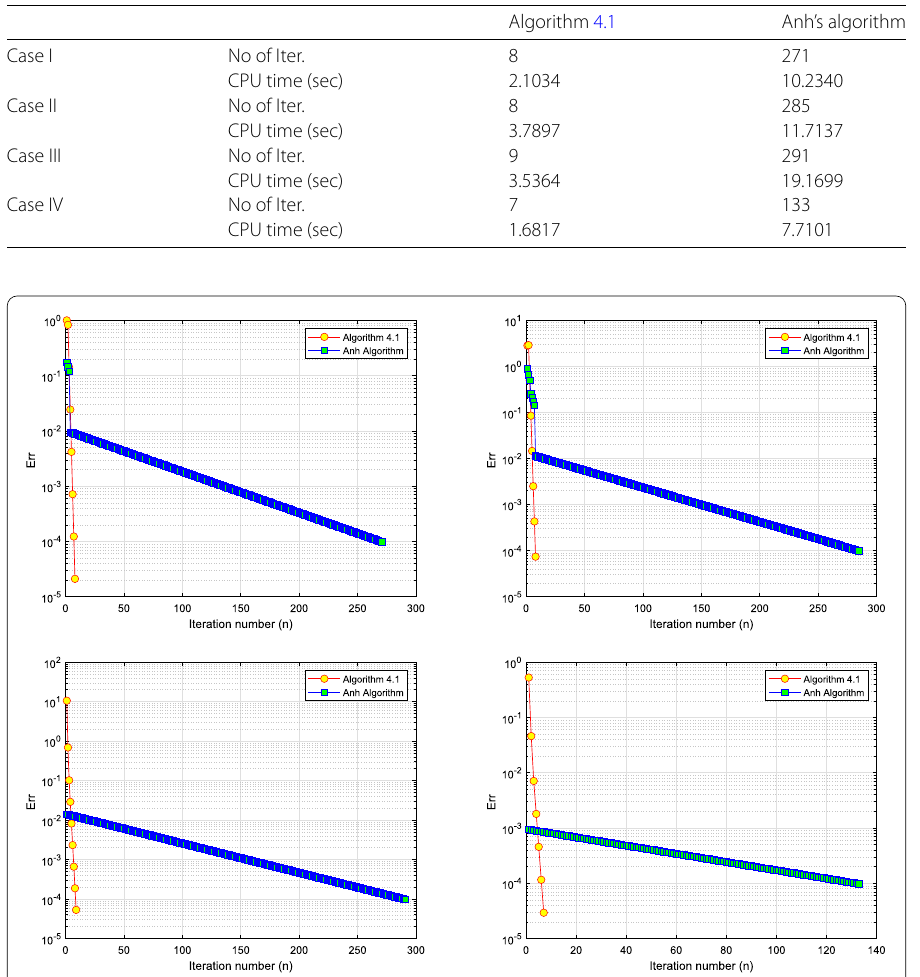
Figure 1 Numerical results, Top Left: Case I; Top Right: Case II; Bottom Left: Case III; Bottom Right: Case